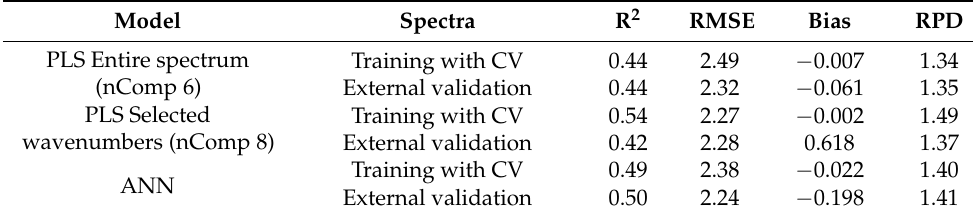
Table 3. Best performing models’ parameters for BH.